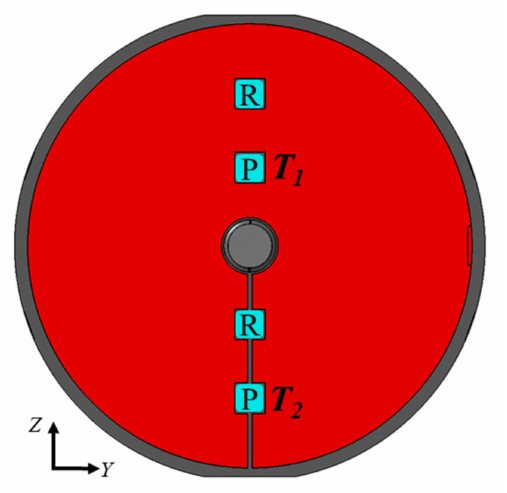
Figure 11. Position of temperature sensors.